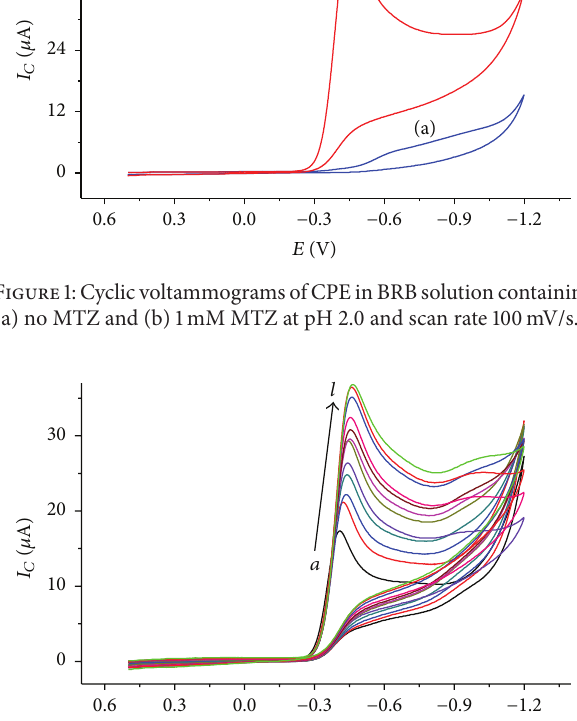
centered at − 450 mV (curve (b) of Figure 1) was observed in the presence of 1 mM metronidazole indicating an irre- versible reduction of metronidazole at